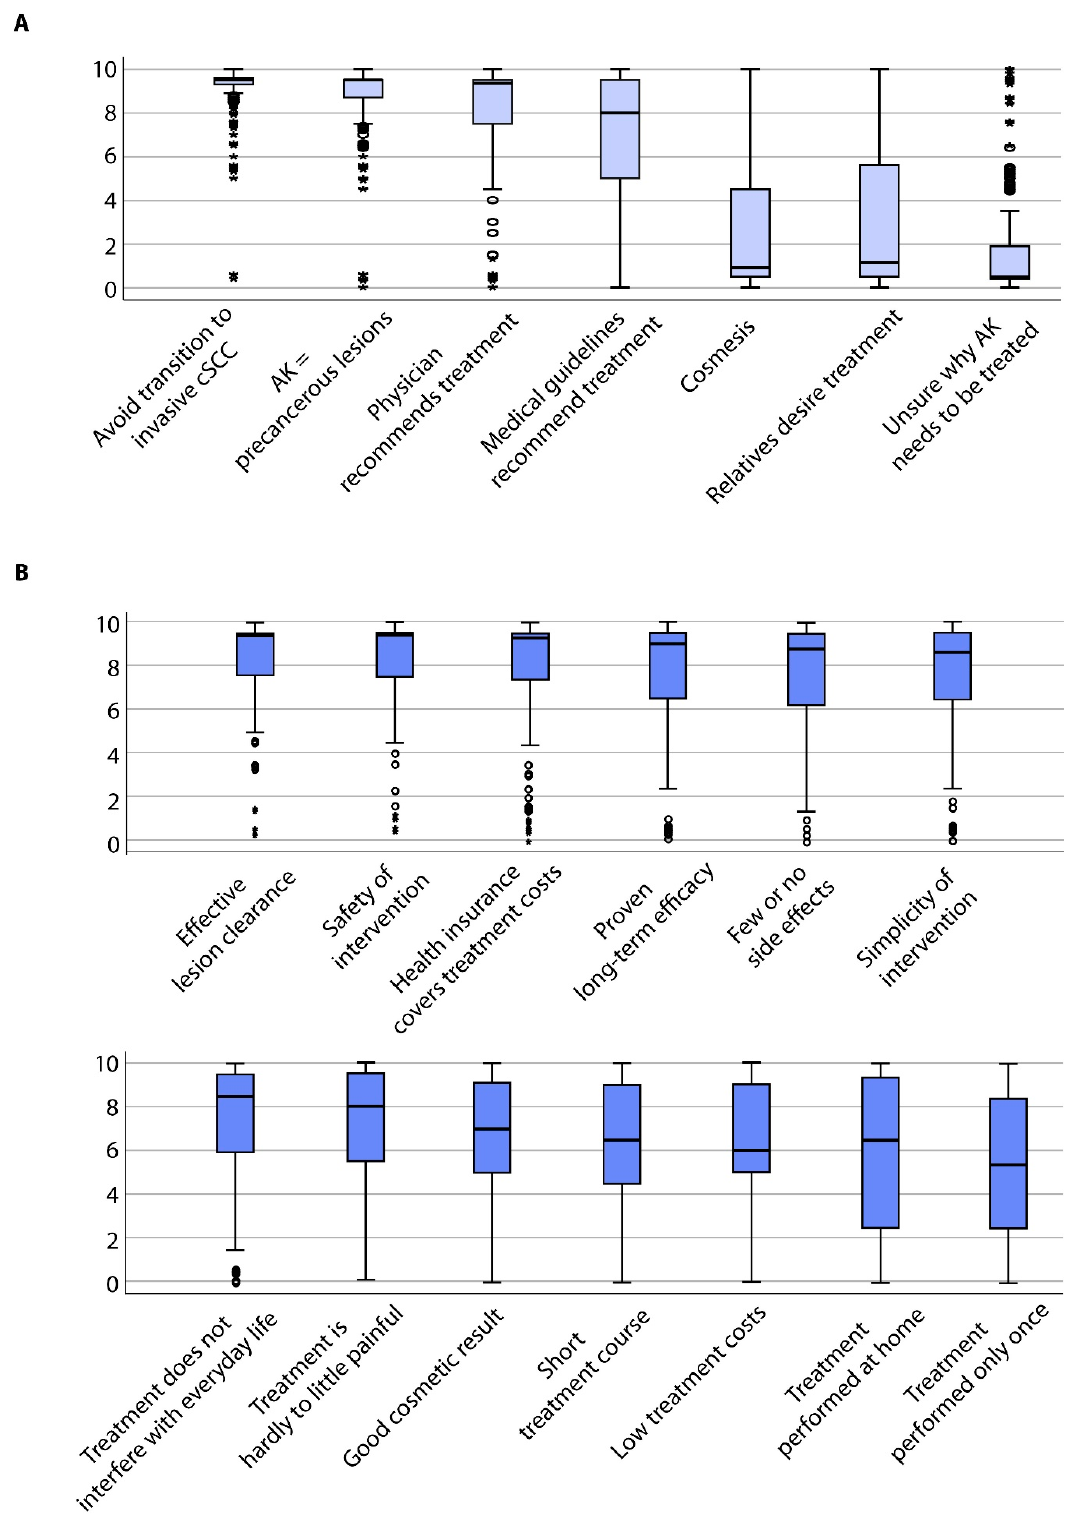
Figure 1. Boxplots showing all patients’ specific evaluation on ( A ) motivation for therapy of their actinic keratoses (AK) and ( B ) on expectations towards therapy of their AK.